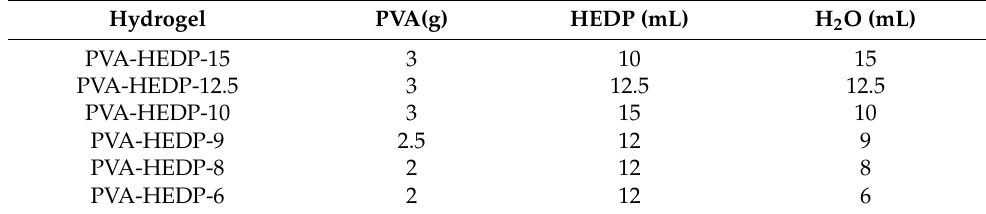
Table 1. Different proportions of PVA-HEDP